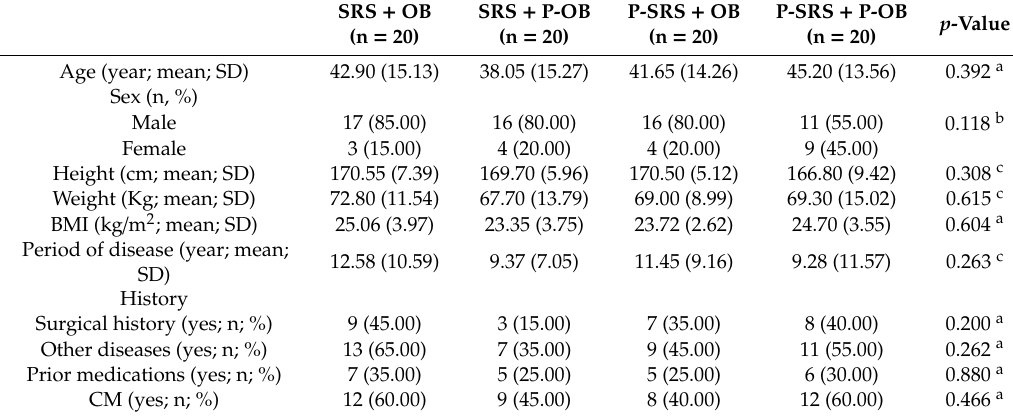
Table 3. Baseline characteristics of the patients (Safety Set).